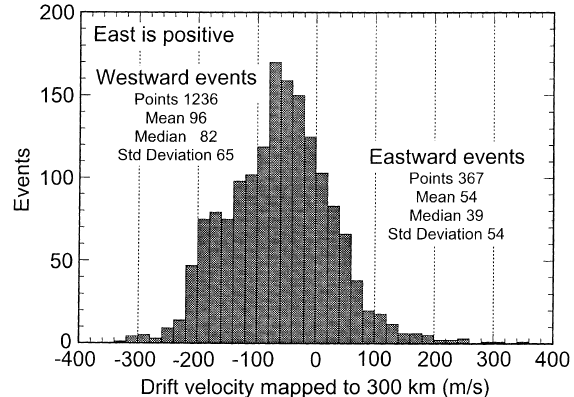
Fig. 13. Results of mapping each individual event in Fig. 11 down, along the field line, to an altitude of 300 km (F-layer). Notice that the westward events (negative values) still travel with a higher speed than the eastward events (positive